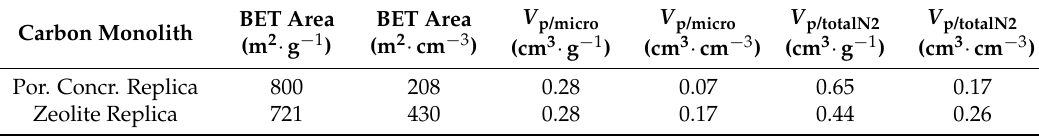
Table 5. Specific mass related and volume related textural data of porous carbon monoliths.